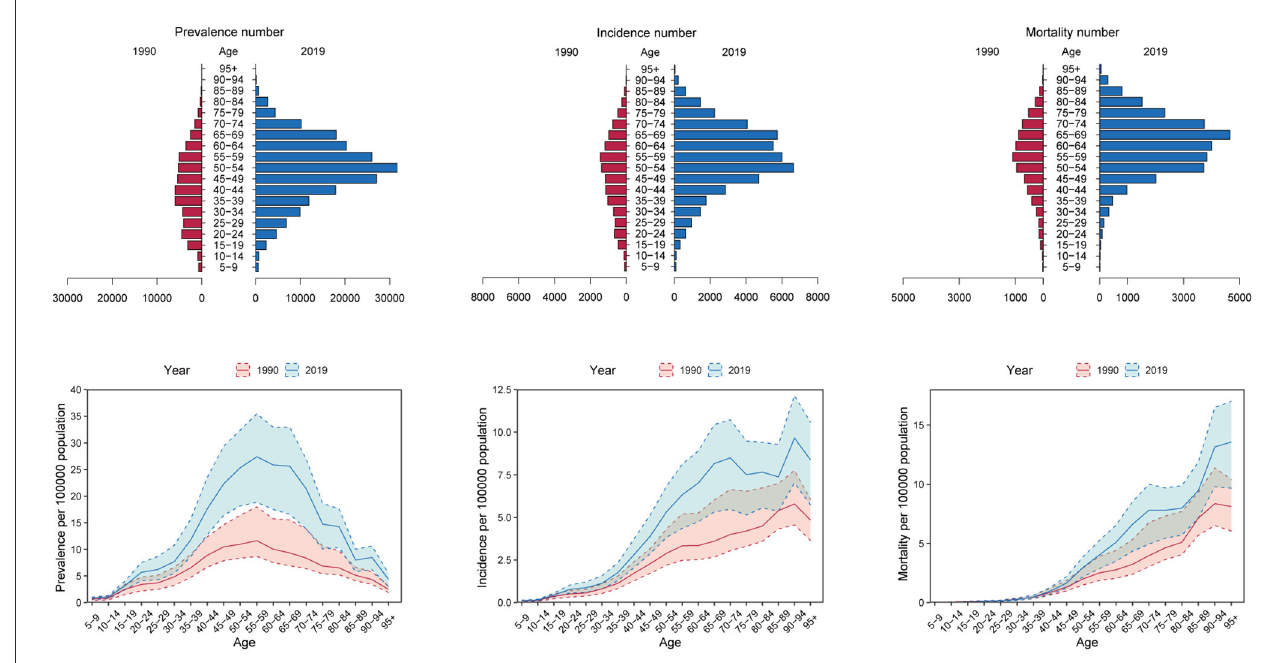
FIGURE2 The numbers and crude rates of ovarian cancer prevalence, incidence and mortality in 2019 compared with 1990 in